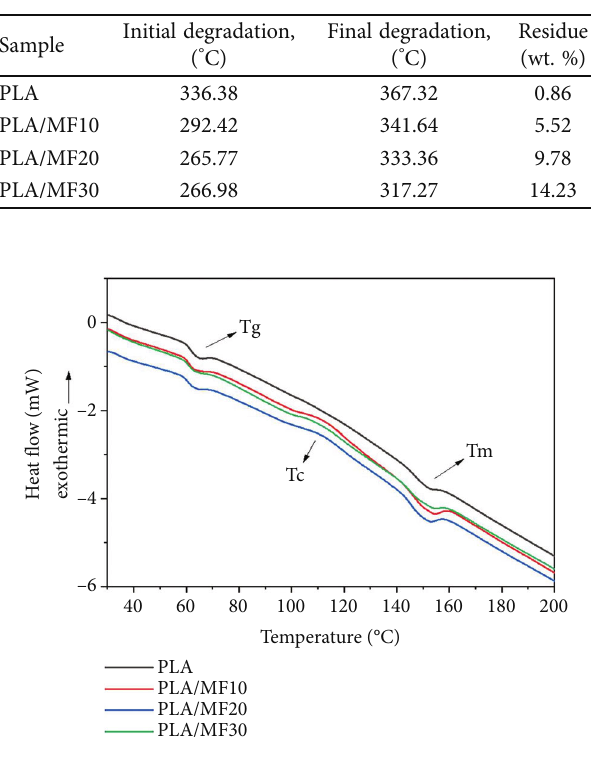
Figure 12: DSC curve of PLA/MF